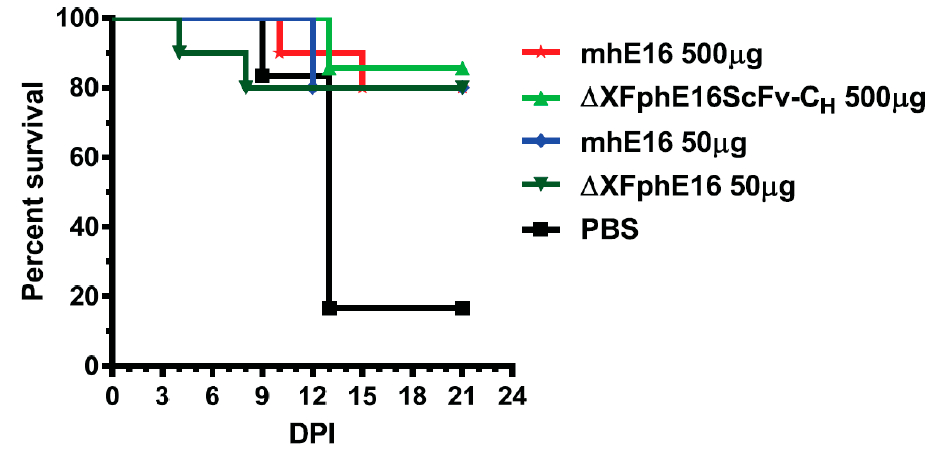
Figure 4. ∆ XFphE16 and ∆ XFphE16scFv-C H mediated protection in mice. Five week-old C57BL/6 mice were infected with 10 2 PFU of WNV and then given a single dose of ∆ XFpE16 (50 μ g), ∆ XFpE16scFv-C H (500 μ g) or mHu-E16 (50 μ g or 500 μ g) via an intraperitoneal route at day +4 after infection. Survival data from at least two independent experiments ( n = 10 mice per dose) were analyzed by the log-rank test. (From [148] with permission from John Wiley and Sons).